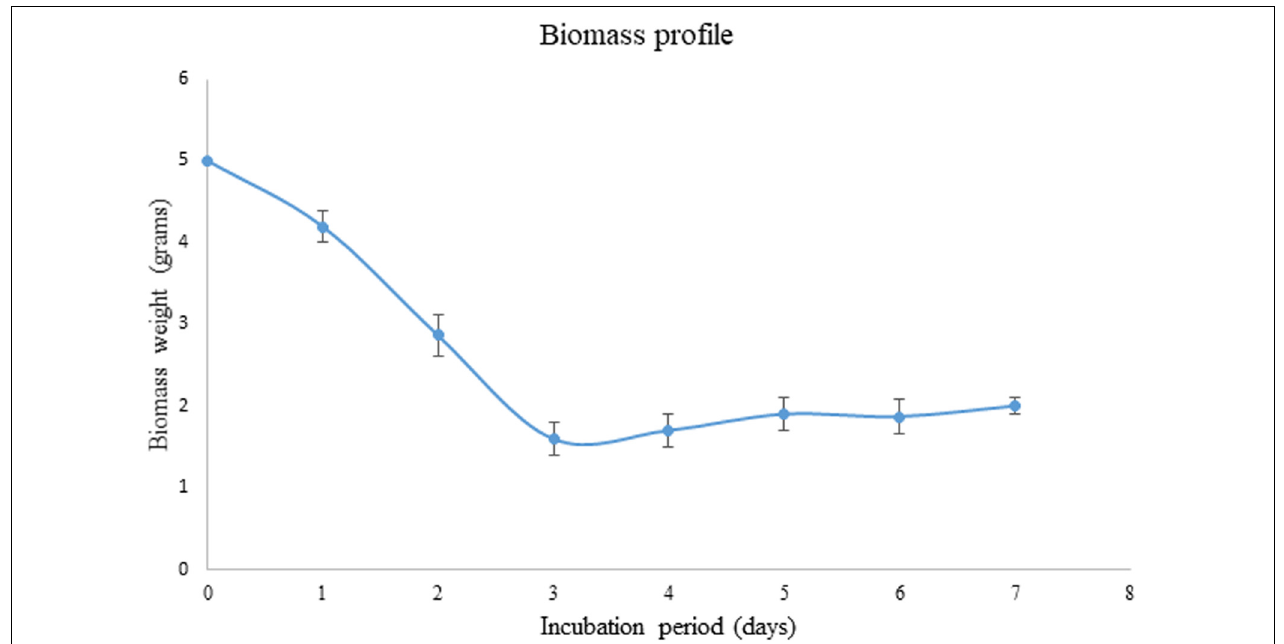
FIGURE 3 | Biomass profile showing the utilization of substrate as carbon source by P. purpurogenum during SSF for the xylanase production. Error bars correspond to standard deviation using three replicates.